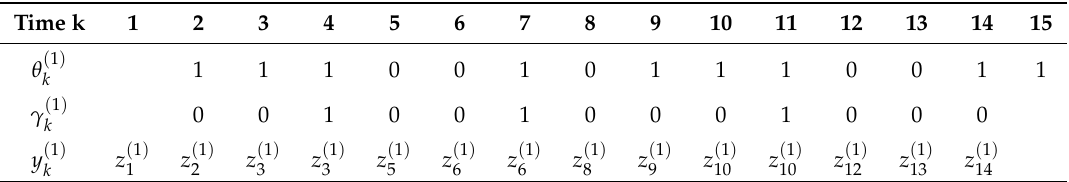
Table 1. Sensor 1 data